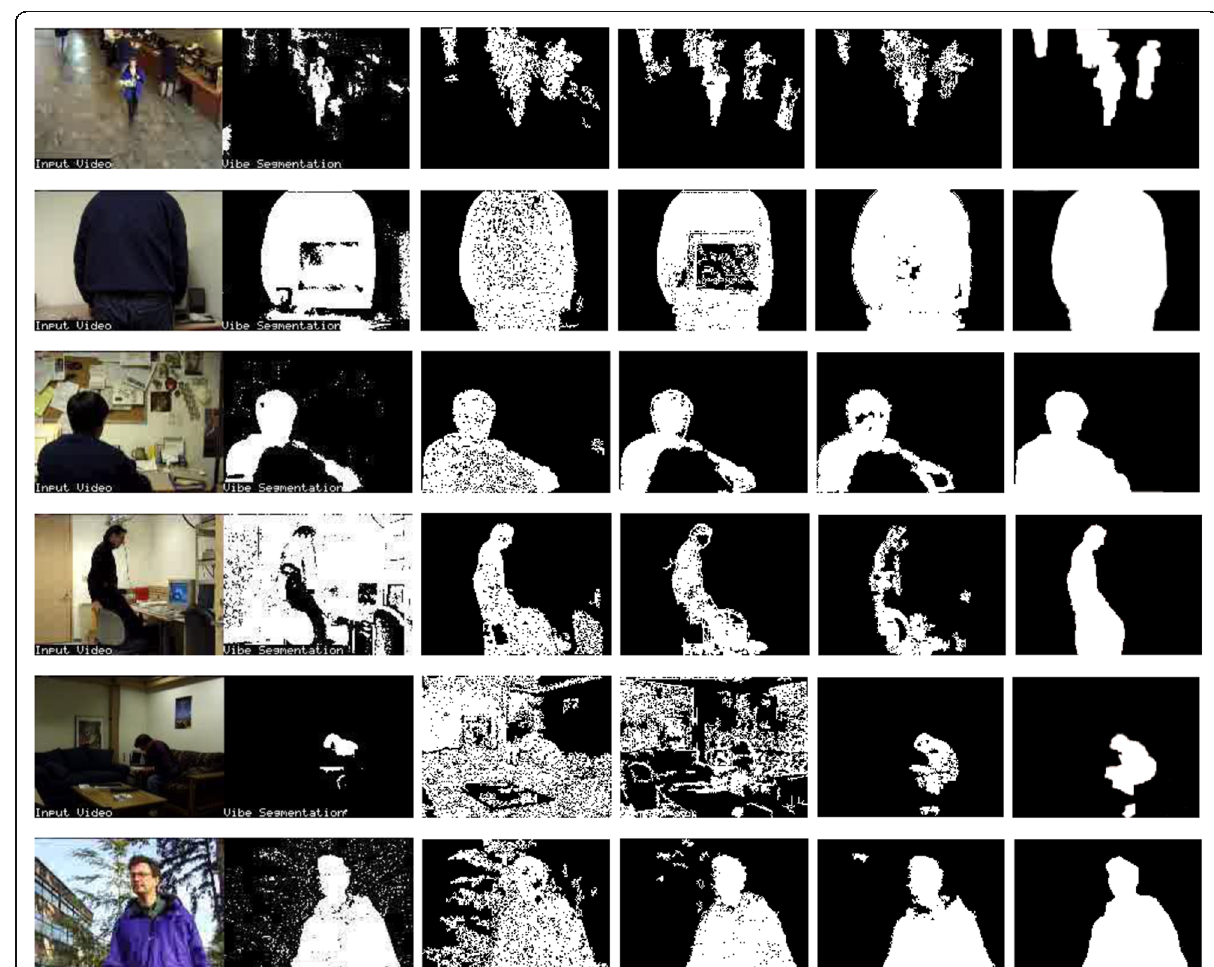
Fig. 10 Background subtraction results on the Wallflower dataset — original image frames (first column), results obtained by ViBe (second column), results obtained by SILTP (third column), results obtained by MC-SILTP (fourth column), results obtained by our method (fifth column), and ground truths (last